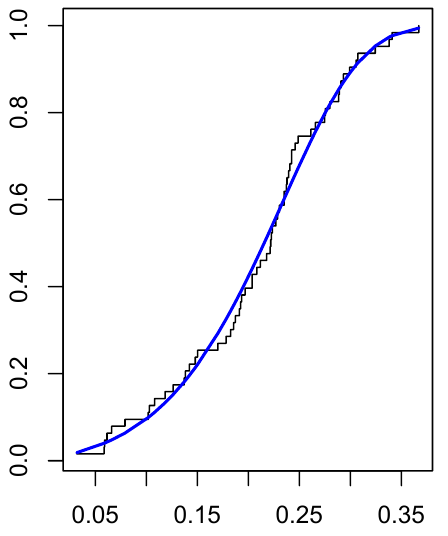
Figure 5. Fit of the distributions for the incidence rate of COVID-19 data set.